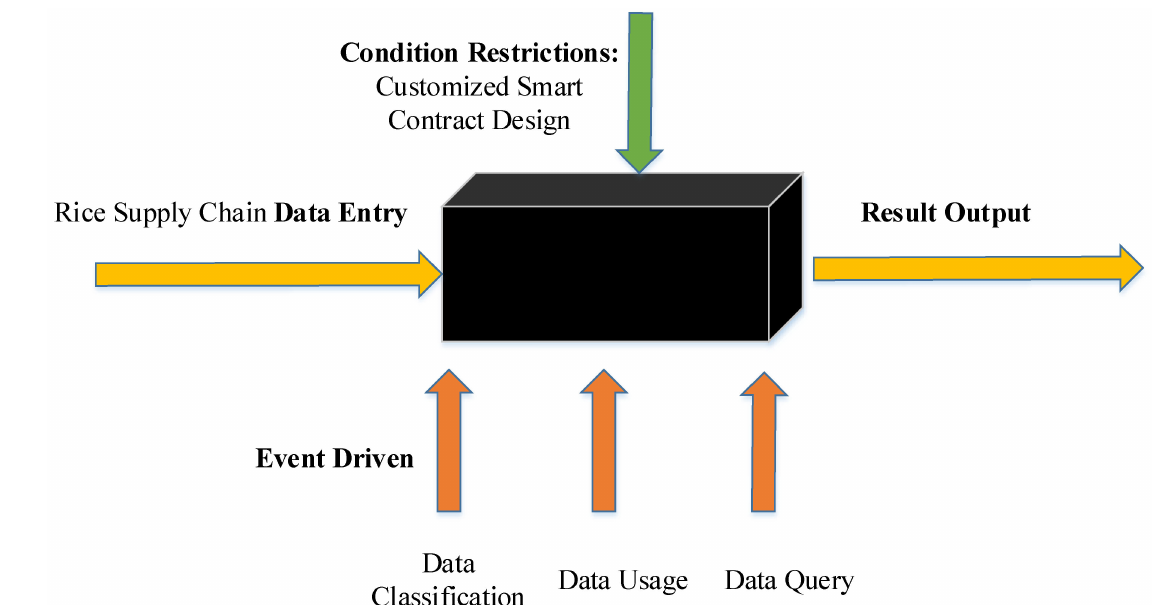
Figure 8. Schematic diagram of black-box testing.